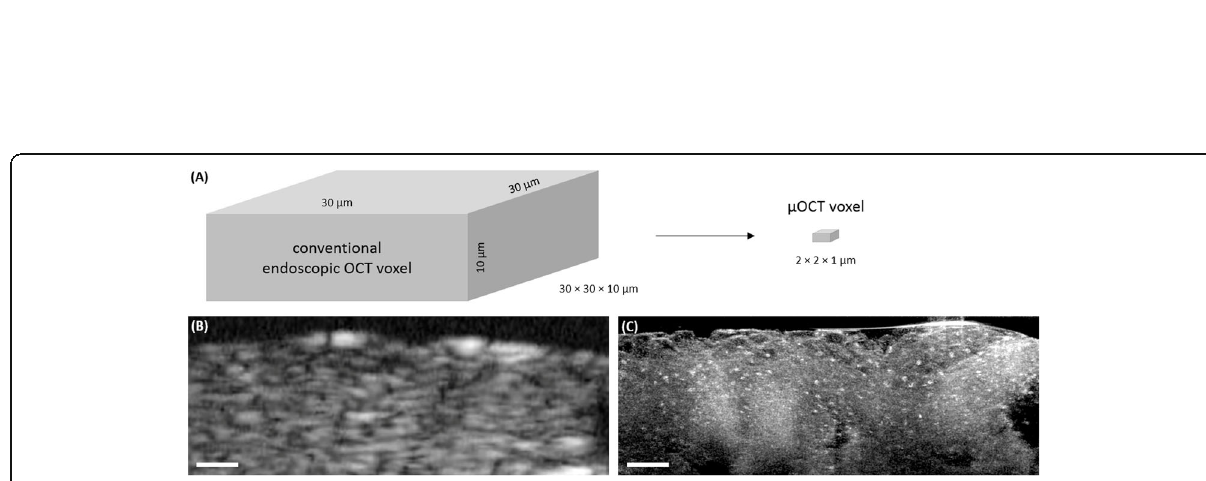
Fig. 6 Milestone 4: Direct comparison between conventional resolution endoscopic OCT and µOCT. a Voxel resolution comparison. b and c benchtop imaging comparison using esophageal biopsies. The cell nuclei in ( c ) were contrast enhanced by application of acetic acid just before image acquisition. Scale bars: 100